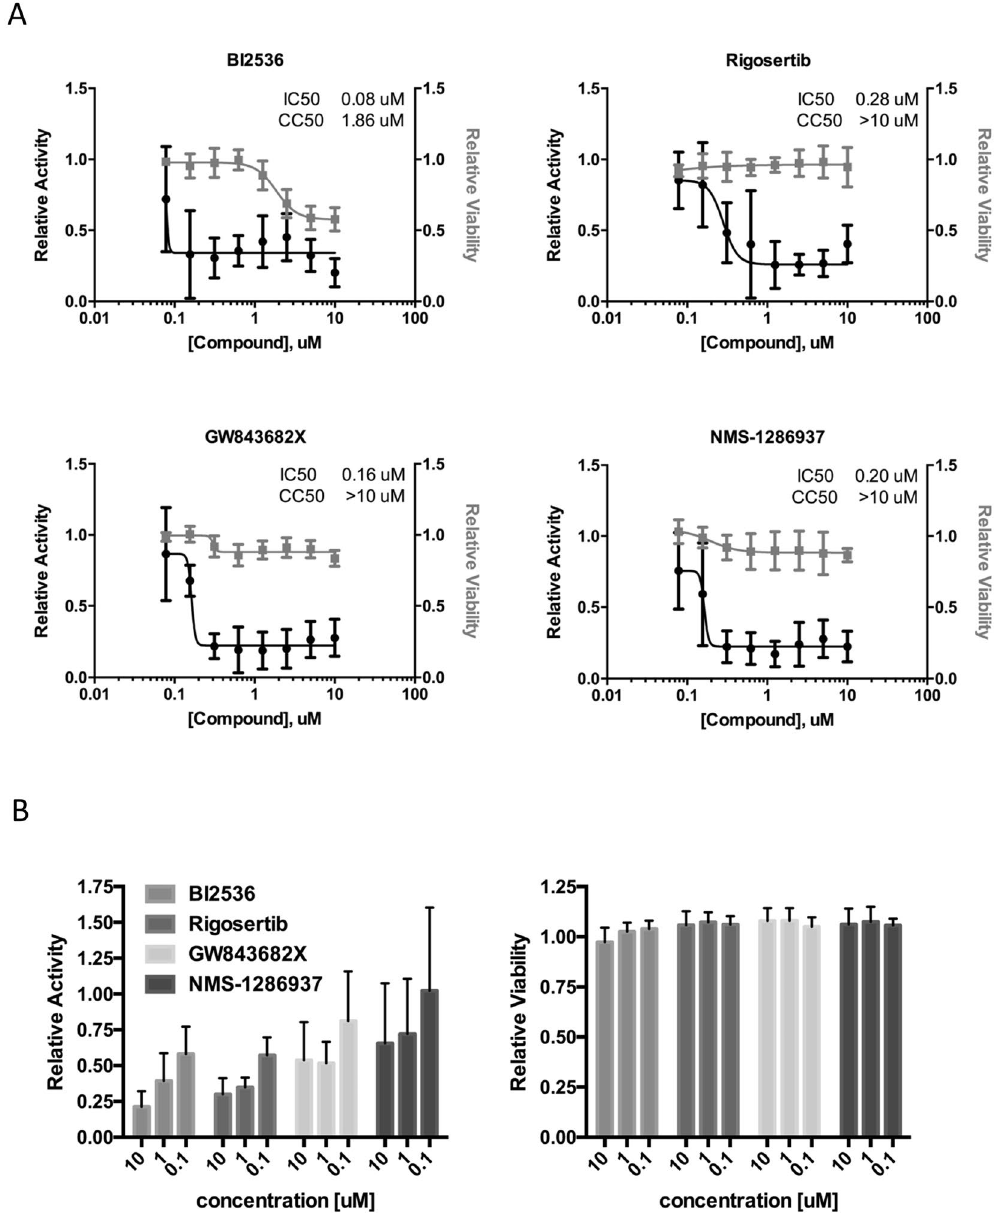
Figure 2. PLK inhibitors efficiently block IAV replication at non-toxic concentrations. The PLK inhibitors BI2536, Rigosertib, GW843682X and NMS-1286937 were used at different concentrations to investigate their effect on replication of recombinant influenza A WSN-Renilla luciferase virus (WSN-Ren). ( A ) PLK inhibitors block IAV in MDCK cells. MDCK-HA cells were pretreated with PLK inhibitors at the indicated concentrations for 2 h and subsequently infected with WSN-Ren at MOI 0.1 or mock treated for 30 hours in presence of inhibitors. Viral replication was assessed by luciferase activity relative to DMSO as control. Cell viability was determined using quantitation of ATP by luminescence relative to DMSO as control. Data were combined from three individual experiments with at least two replicates each. Shown are means with standard deviation. ( B ) PLK inhibitors block IAV in A549 cells. A549 cells were pretreated with PLK inhibitors at the indicated concentrations for 2 h, infected with WSN-Ren at MOI 3 or mock treated for 6 hours in the presence of inhibitors. Viral replication was assessed by measuring luciferase activity relative to DMSO as control. Data were combined from four experiments with two or more replicates each; shown are means with standard